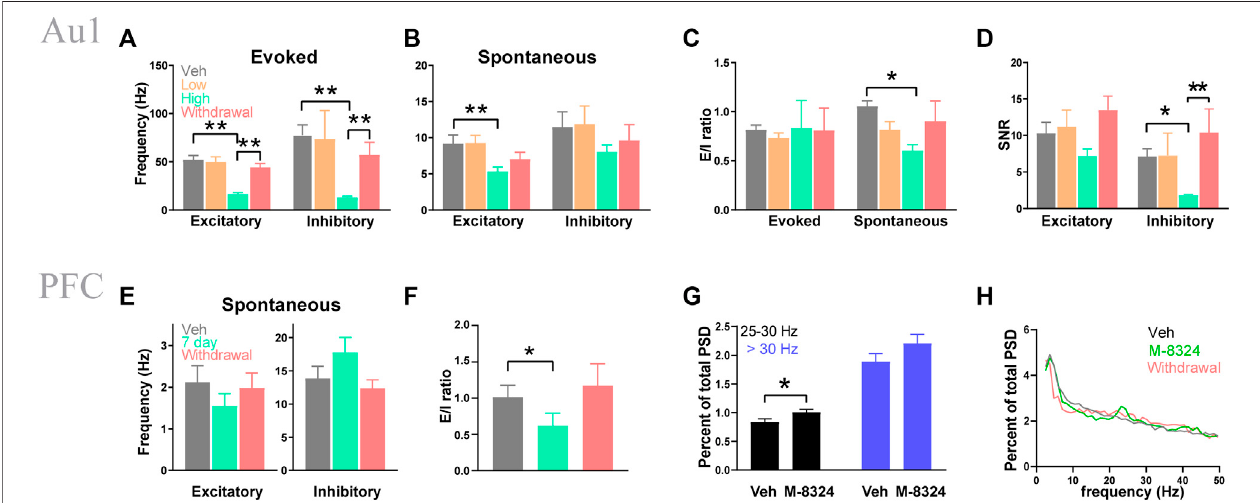
FIGURE 1 | Seven-day infusion of M-8324 altered sound-evoked and spontaneous spiking in Au1 and PFC in vivo . (A) A signi fi cantly lower sound-evoked spike frequencyinthehigh-dosegroupwhichrecovered1weekafterM-8324withdrawalinbothexcitatoryandinhibitoryneuronsinAu1. (B) Asigni fi cantlylowerspontaneous spike frequency in excitatory neurons in the high-dose group in Au1. (C) A signi fi cantly higher E/I ratio in spontaneous spiking in excitatory neurons in the high-dose group. (D) A signi fi cantly lower signal-to-noise (SNR) in inhibitory neurons in the high-dose group. In A – D , for excitatory neurons, N (cid:2) 70 cells/6 mice (vehicle), 49 cells/6 mice (M-8324 100 µM), 100 cells/6 mice (M-8324 300 µM), 73 cells/6 mice (withdrawal). For inhibitory neurons, N (cid:2) 17 cells/6 mice (vehicle), 7 cells/6 mice (M- 8324 100 µM), 25 cells/6 mice (M-8324 300 µM), 22 cells/6 mice (withdrawal). (E) Spontaneous spiking frequency did not change in inhibitory neuron in PFC after